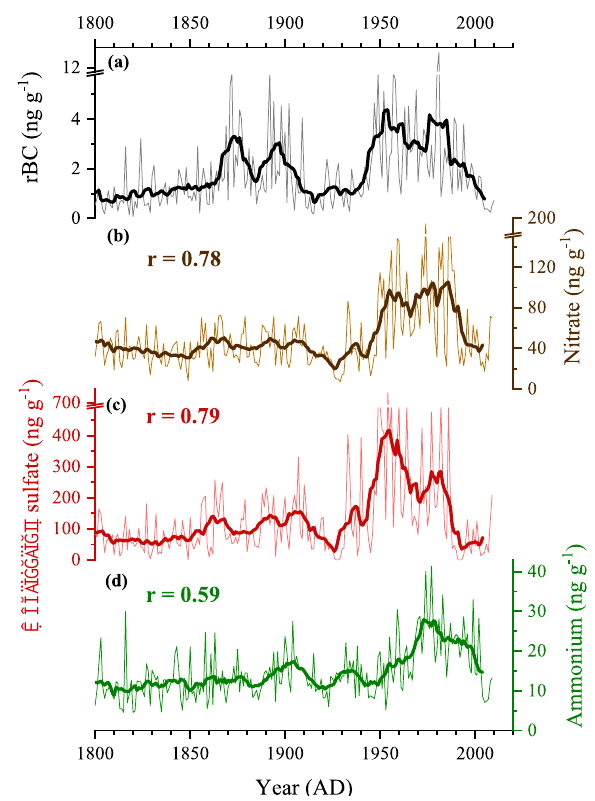
Figure 4. (a) rBC, (b) nitrate, (c) non-sea-salt sulfate, and (d) am- monium records from 1800 on. The rBC record is combined for LF-09 and LF-11 spanning 1800–2010 while the other records only show LF-09 data spanning 1800–2009 (Wendl et al., 2015). Thin lines represent annual averages. Bold lines are 11-year moving aver- ages and are associated with Pearson correlation coefficients ( r val- ues) between the respective ion records and the rBC